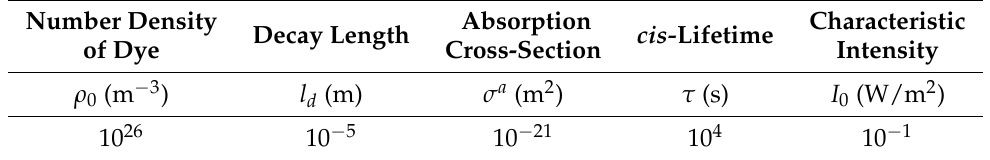
Table 2. Material parameters of the azo-acrylate